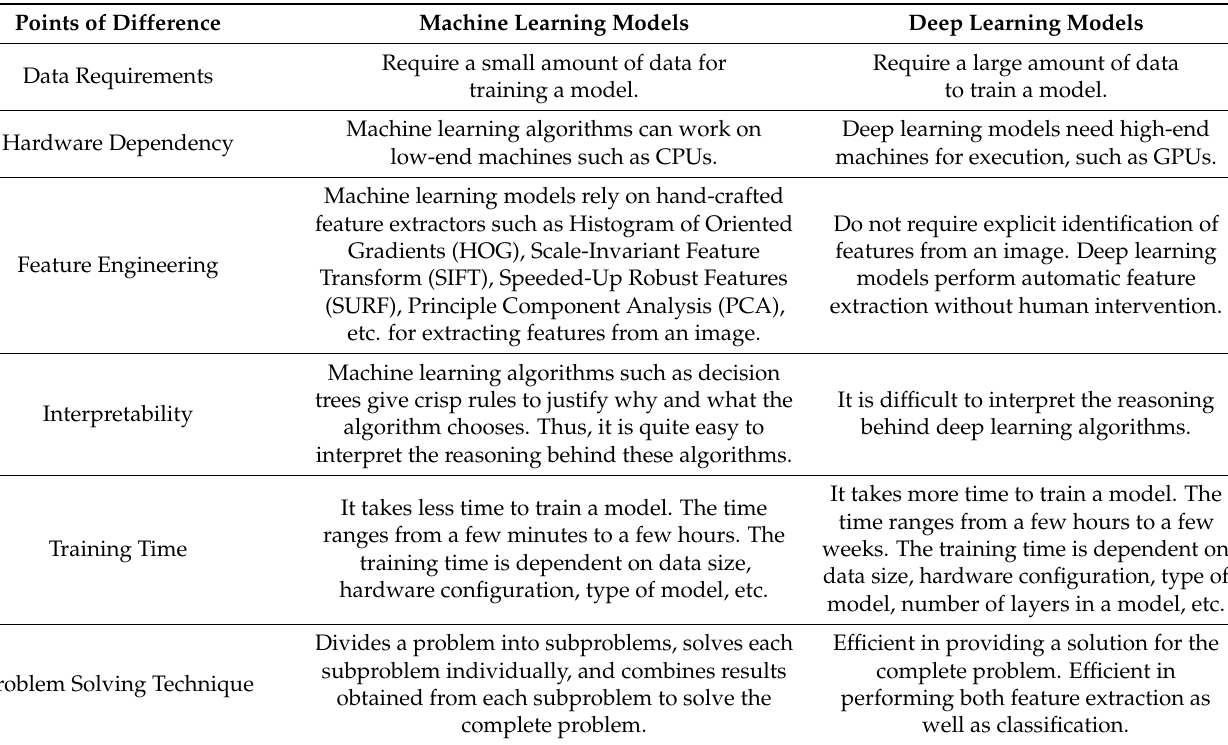
Table 1. Comparison of machine learning and deep learning